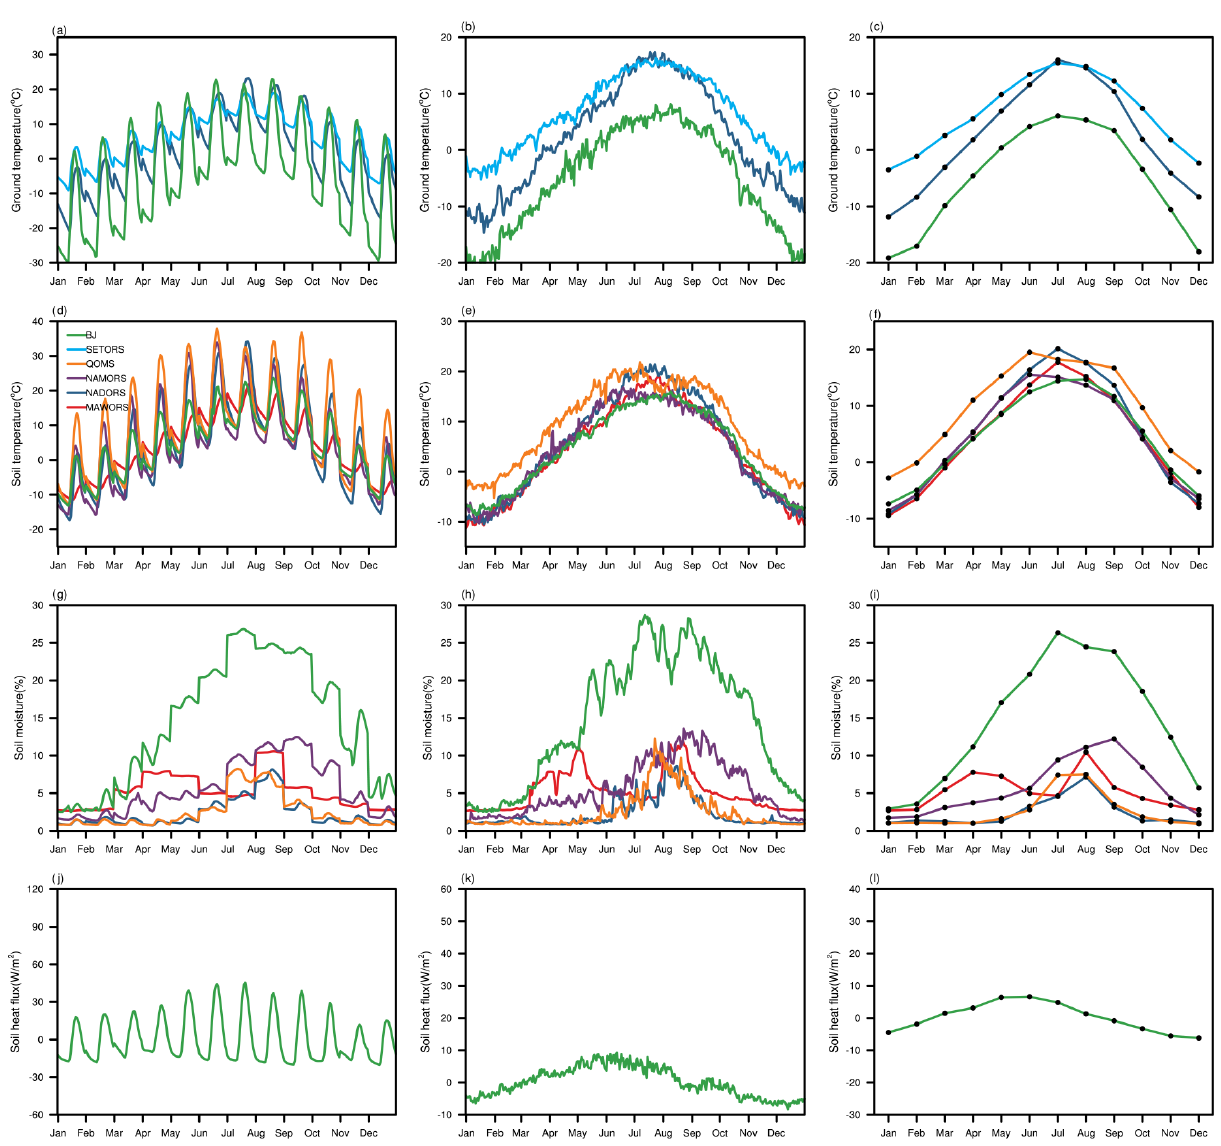
Figure 5. Same as Fig. 2, but for the climatological average of ground temperature and first-layer (except for the observations at depths of 0cm) soil temperature, soil moisture and soil heat